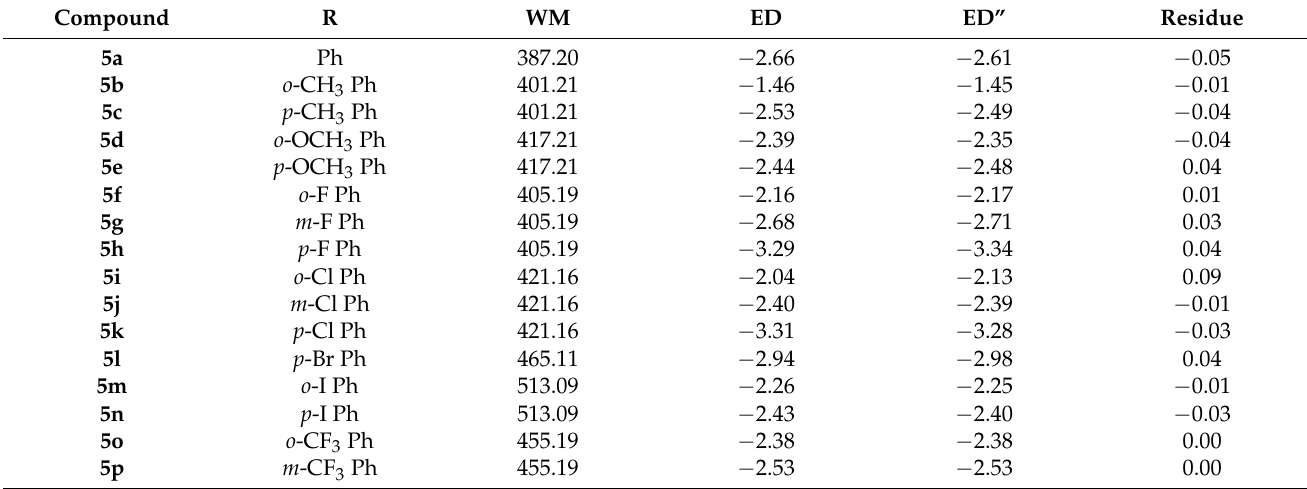
Table 3. The ED values of experimental and predicted